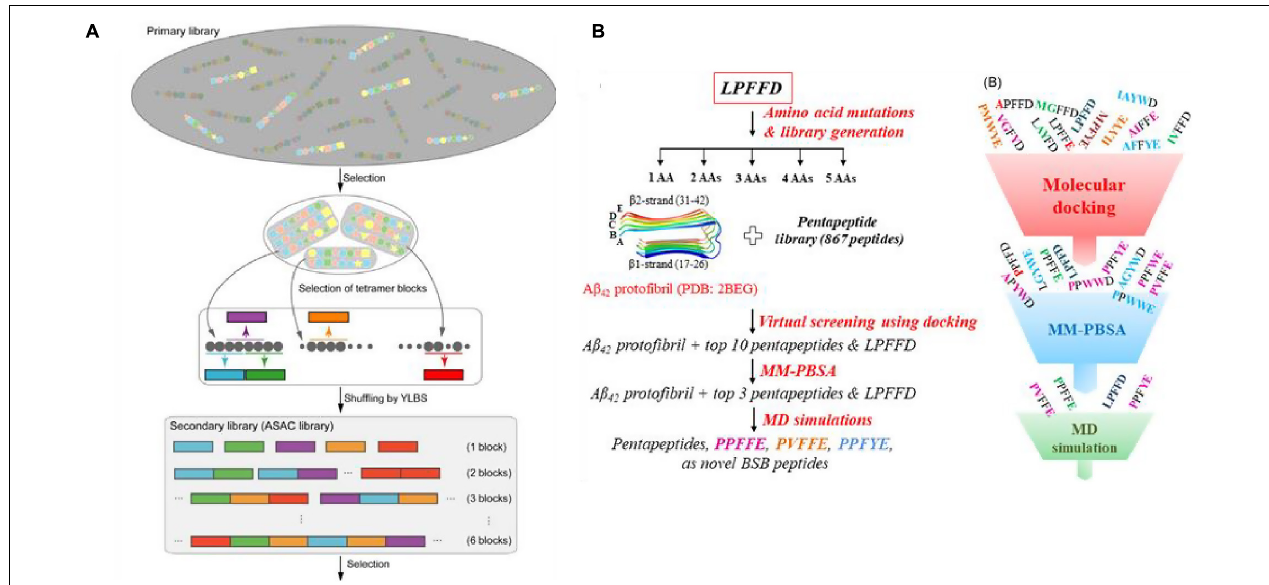
FIGURE 4 | (A) Illustration of the designated progressive library method (PLM) (Tsuji-Ueno et al., 2011; Ghimire Gautam et al., 2015); (B) schematic illustration of the in silico screening workflow for designing novel β -sheet breaker peptides (Shuaib et al., 2019). Reproduced with permission.